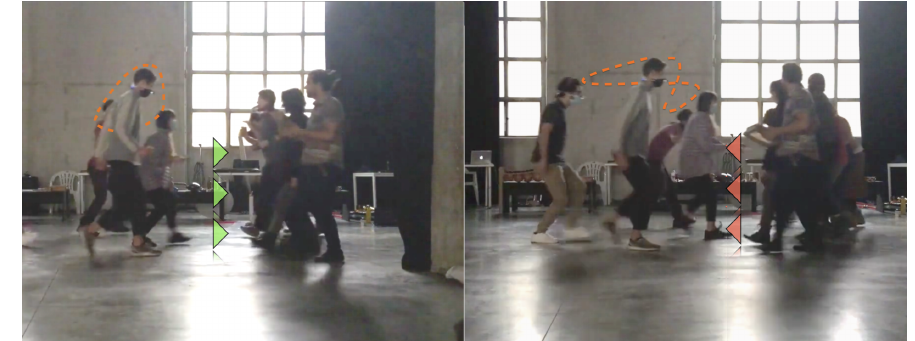
Figure 5. Annotations from Scene iii rehearsal video. The arrows show the walking direction with a dashed line to trace the dispersion of mask-wearing group. A video recording is included in the Supplementary Material.